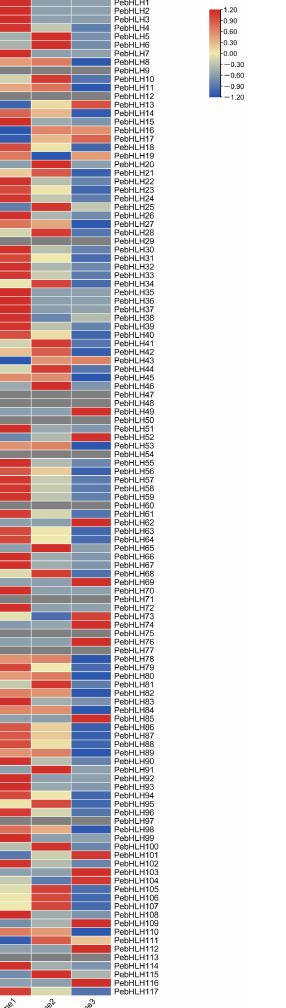
Figure 8. qRT-PCR analysis of 8 PebHLHs under 4 different abiotic stresses (Table S3) . Horizontal coordinates indicate different stress treatments (the different processing methods are described above), and vertical coordinates represent relative expression values. The different letters mean significance, which was examined by Duncan’s range test ( p < 0.05).